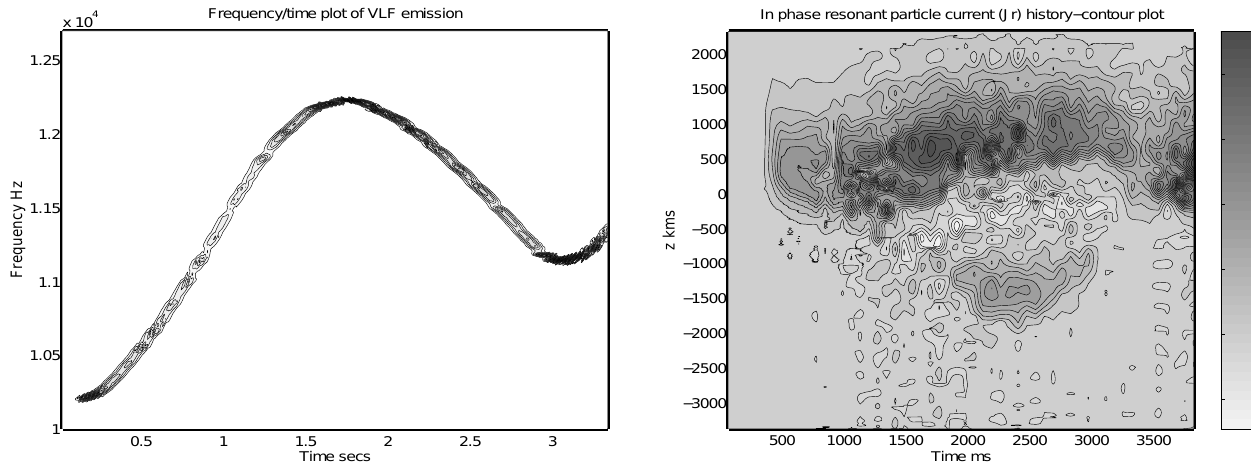
Fig. 19. Run 3. History of in phase current − J r in units of J r (lin). Large positive values are evident 500km upstream from the “am- plitude